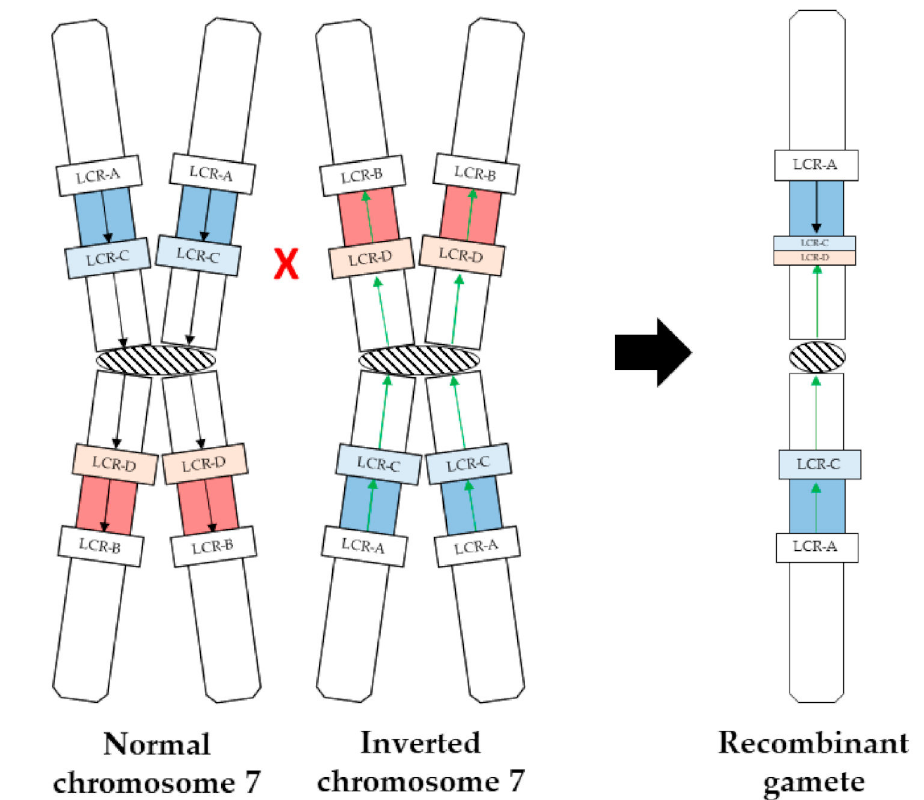
Figure 3. Schematic of the model proposed to explain the mechanism leading to the recombinant gamete. Left: normal and inverted maternal chromosome 7; right: proband’s recombinant chromatid. The black and green arrows indicate, respectively, the normal and inverted orientations of the region involved in maternal inversion. Localization of LCR-A,-B,-C,-D is indicated. The red cross points to the approximate non-allelic homologous recombination (NAHR)